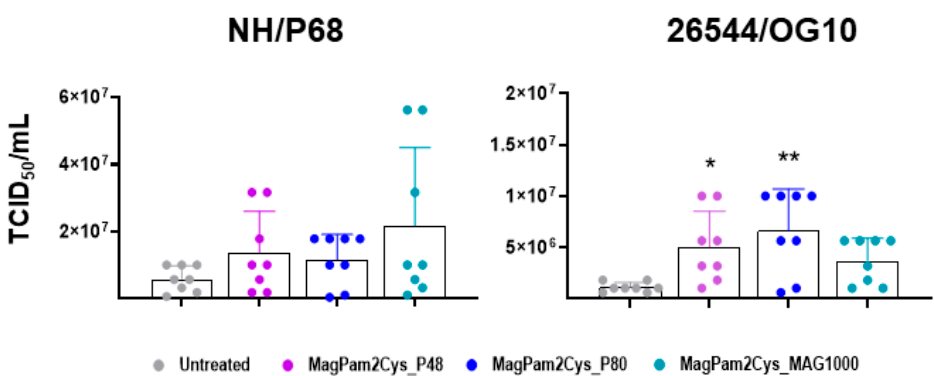
Figure 6. Effect of MagPam2Cys_P48 on cytokine release by moM Φ in response to ASFV infection. Porcine moM Φ were either left untreated or stimulated with MagPam2Cys_P48, MagPam2Cys_P80, or MagPam2Cys_MAG1000 (all at 100 ng/mL). Twenty-four hours later, cells were infected with either attenuated NH/P68 or virulent 26544/OG10, using a MOI of 1. Mock-infected samples were used as controls. At 21 hpi, culture supernatants were collected, and levels of IL-1 α , IL-1 β , IL-1Ra, and IL-18 were determined using a multiplex ELISA. The mean data ± SD from three independent experiments using different animals are presented. For each macrophage subset, values of ASFV-infected macrophages were compared to the corresponding mock-infected control, using a one-way ANOVA followed by Dunnett’s multiple comparison test or a Kruskal–Wallis test followed by Dunn’s multiple comparison test; *** p < 0.001, ** p < 0.01, * p < 0.05.